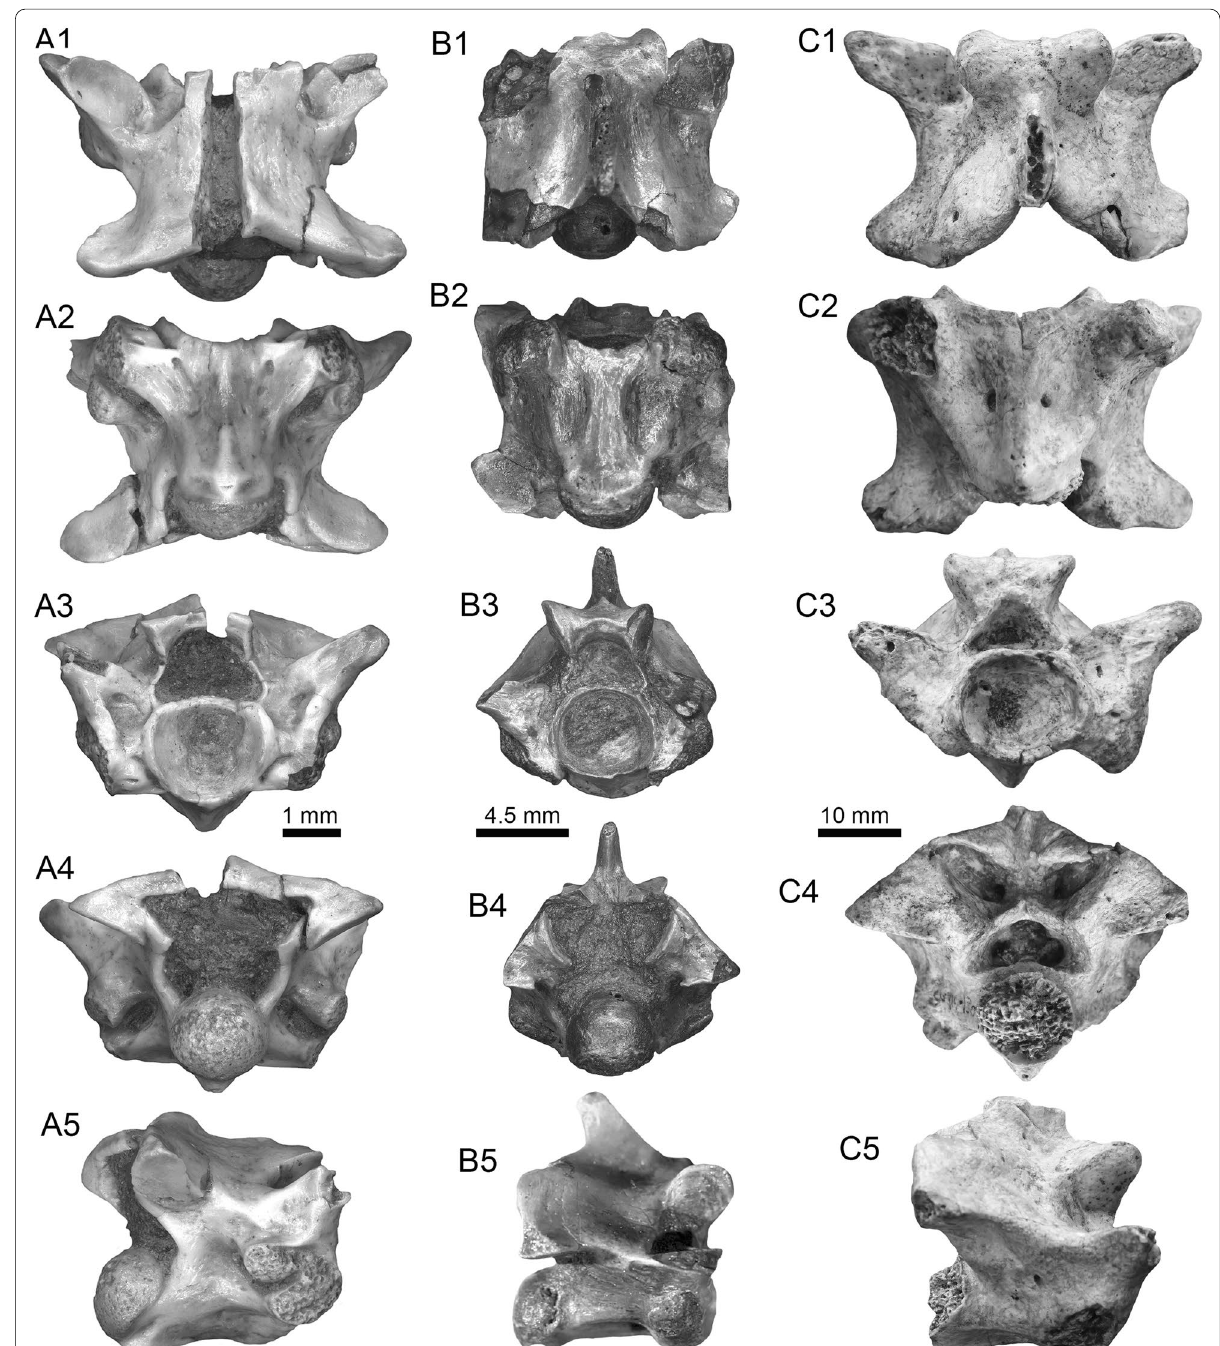
Fig. 17 Serpentes (Aniliidae and Boidae) from the Vergel Member. A1 – A5 Trunk vertebra of Anilius scytale (AMU‑CURS‑1159). B1 – B5 Trunk vertebra of Corallus sp. (AMU‑CURS‑1157). C1 – C5 Trunk vertebra of Eunectes sp. (AMU‑CURS‑1304). Views: anterior ( A3 , B3 , C3 ), dorsal ( A1 , B1 , C1 ), right lateral ( A5 , B5 , C5 ), posterior ( A4 , B4 , C4 ), and ventral ( A2 , B2 , C2